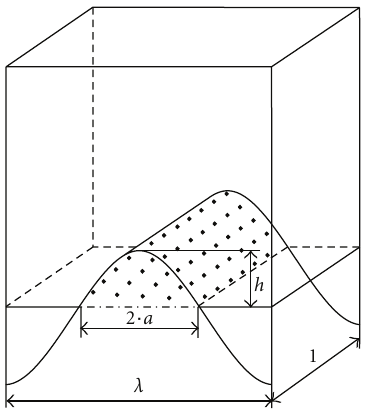
Figure 11: Illustration of a sine wave pressed against a rubber block.